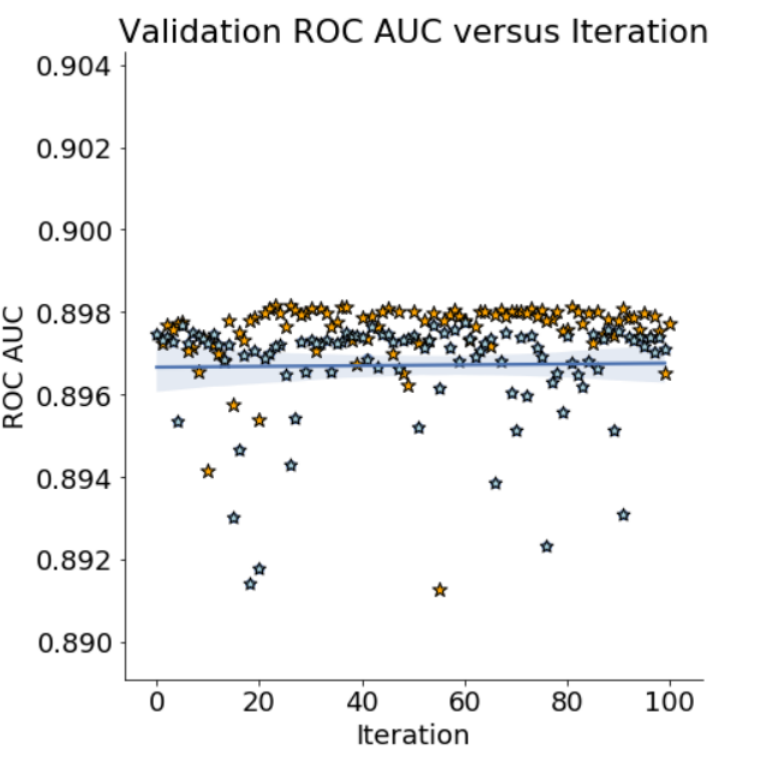
Figure 1. Highest Validation Score at each Iteration for AHBO-TPE (yellow) and Random Search (blue) (Ember Dataset).